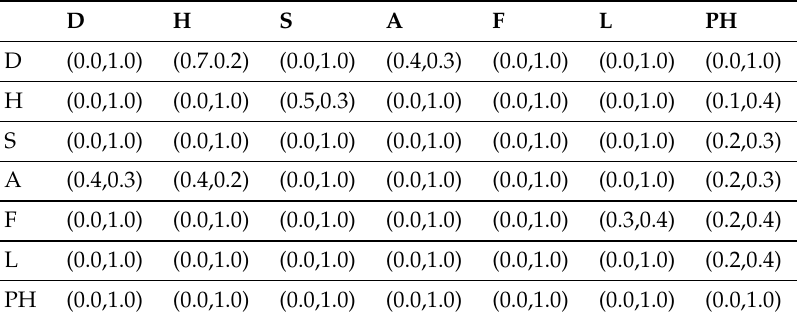
Table 4. AM corresponding to Figure 19.